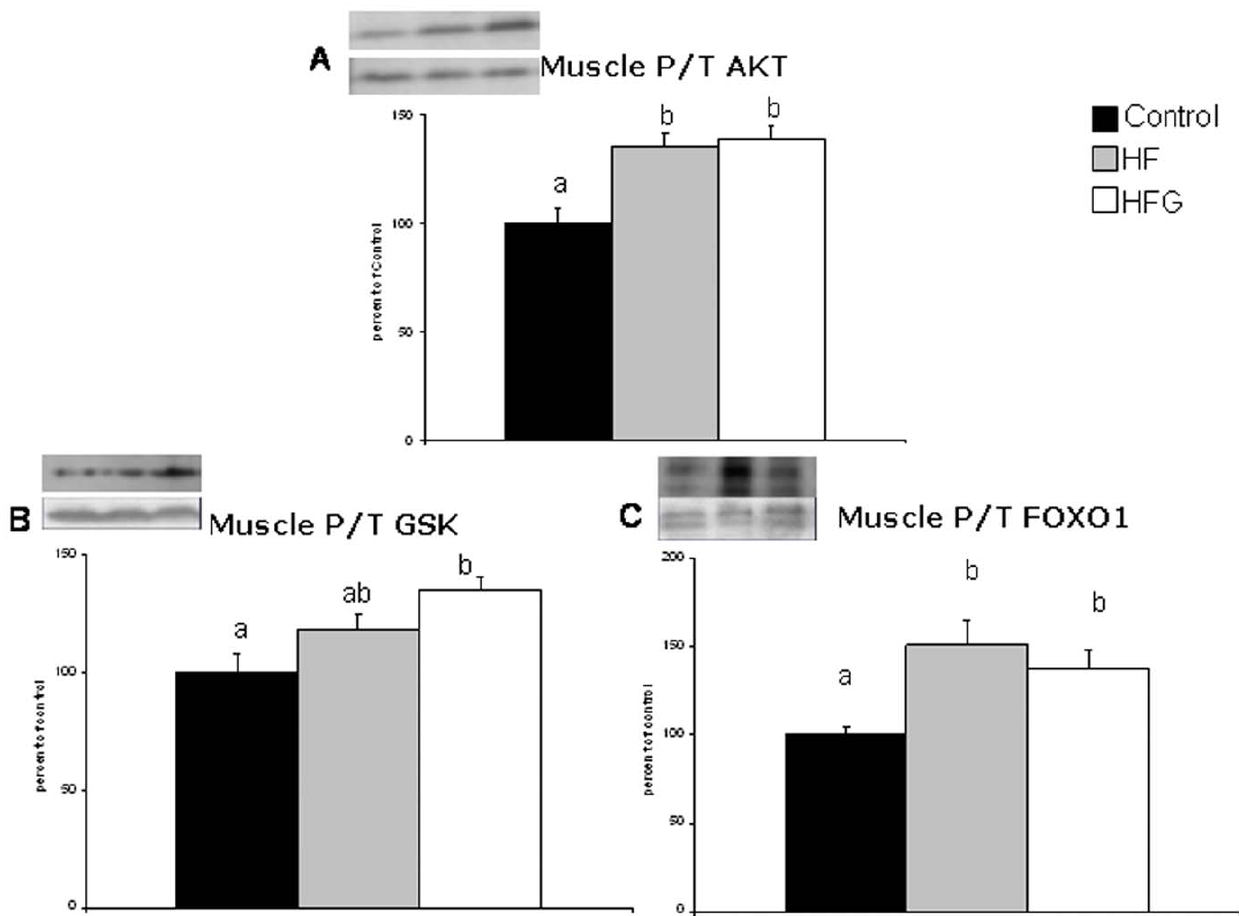
Figure 4. Acylated ghrelin during HF diet does not alter AKT-dependent gastrocnemius insulin signaling. Effects of one-month high-fat feeding without (HF) or with (HFG) 4-day acylated ghrelin treatment on gastrocnemius muscle phosphorylation of AKT (a), glycogen synthase kinase (GSK) (b) and FOXO1 (c). Different letters denote statistically significant differences (P , 0.05 ANOVA and post-hoc test).